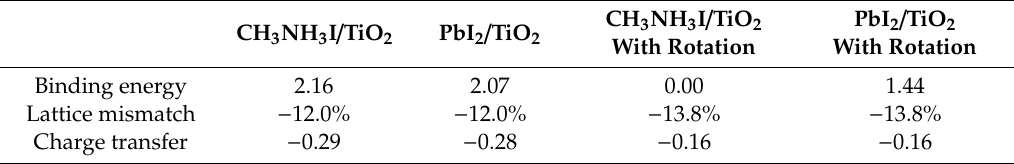
Table 2. Interfacial binding energy (in eV) and lattice mismatch of the CH 3 NH 3 PbI 3 / TiO 2 interfaces.